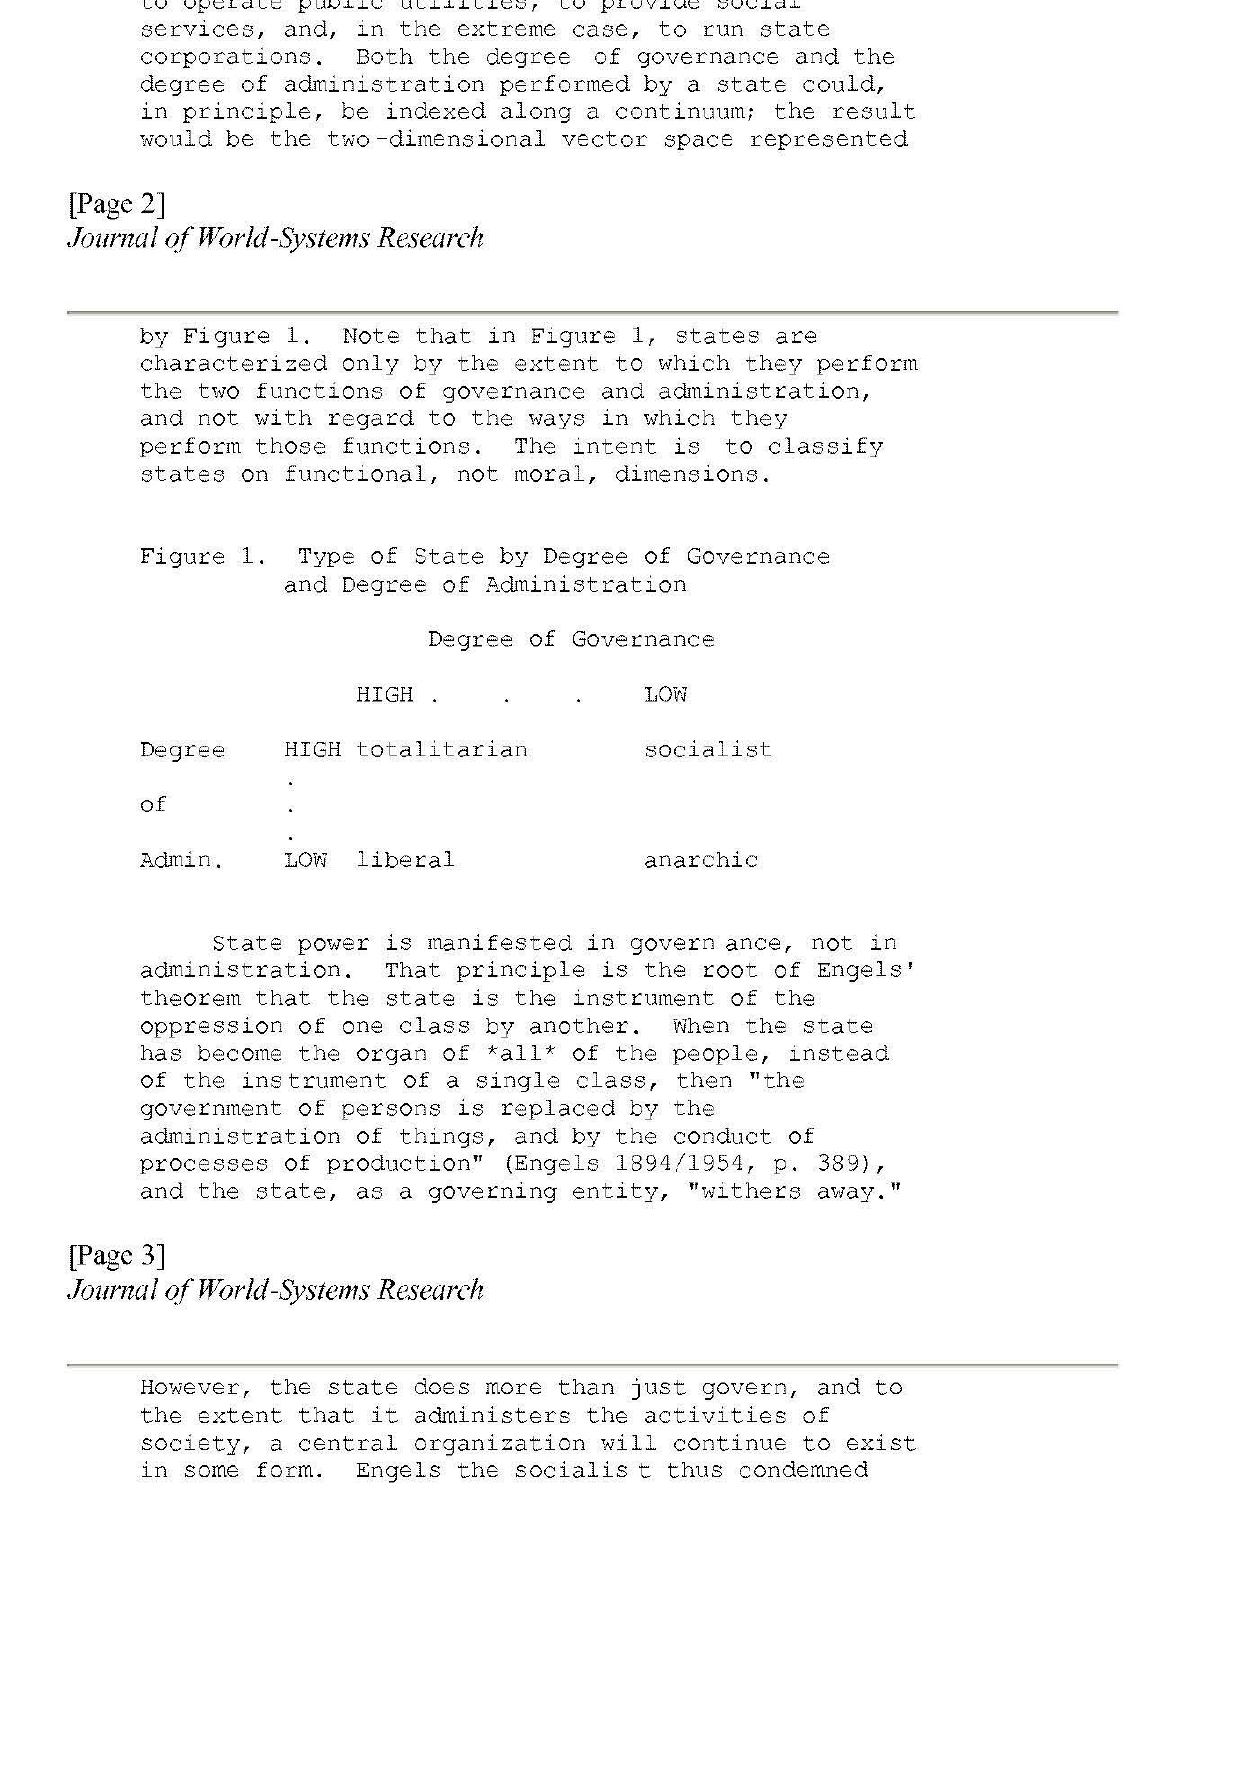
Figure 1. Type of State by Degree of Governance and Degree of Ad.ministration